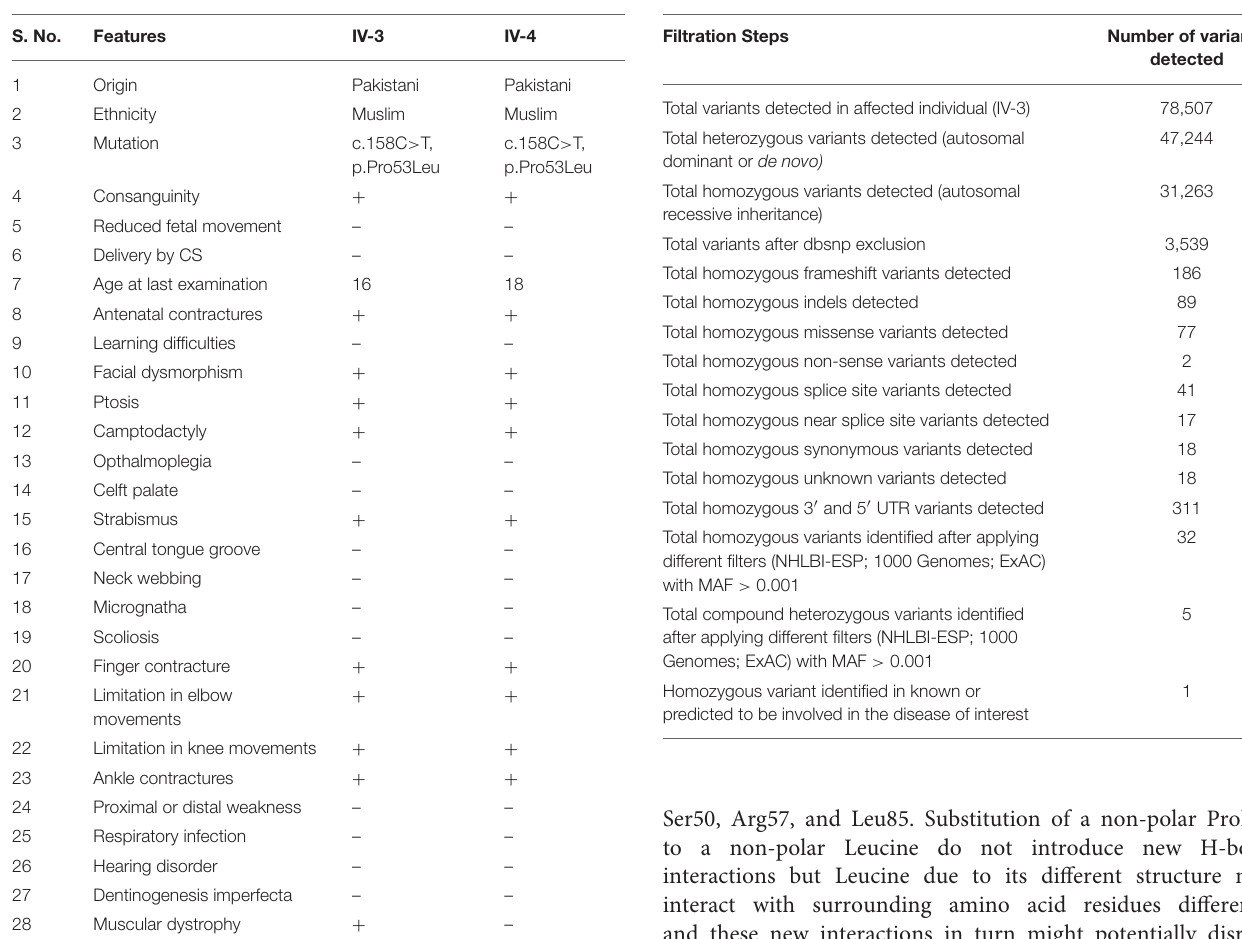
TABLE 2 | Filtering steps followed to identify the disease causing